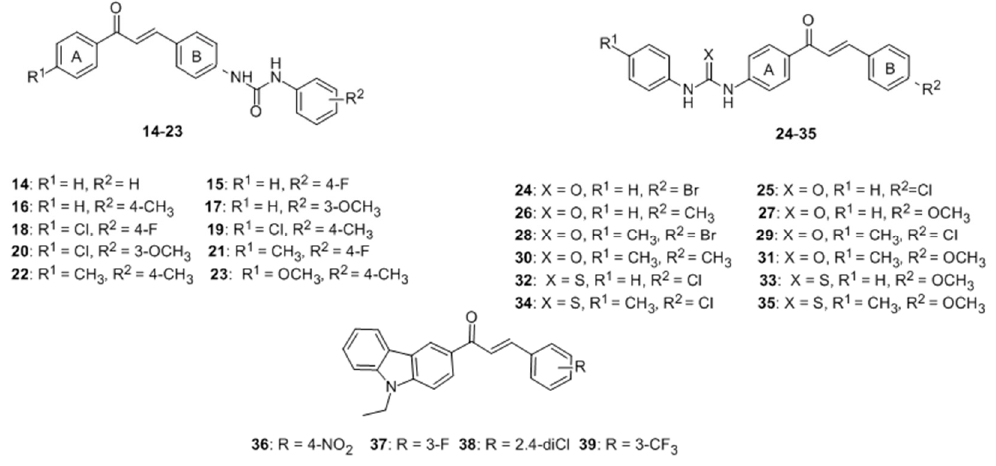
Figure 7. Structures of chalcone derivatives and analogues with activator effect on tyrosinase [68,69].